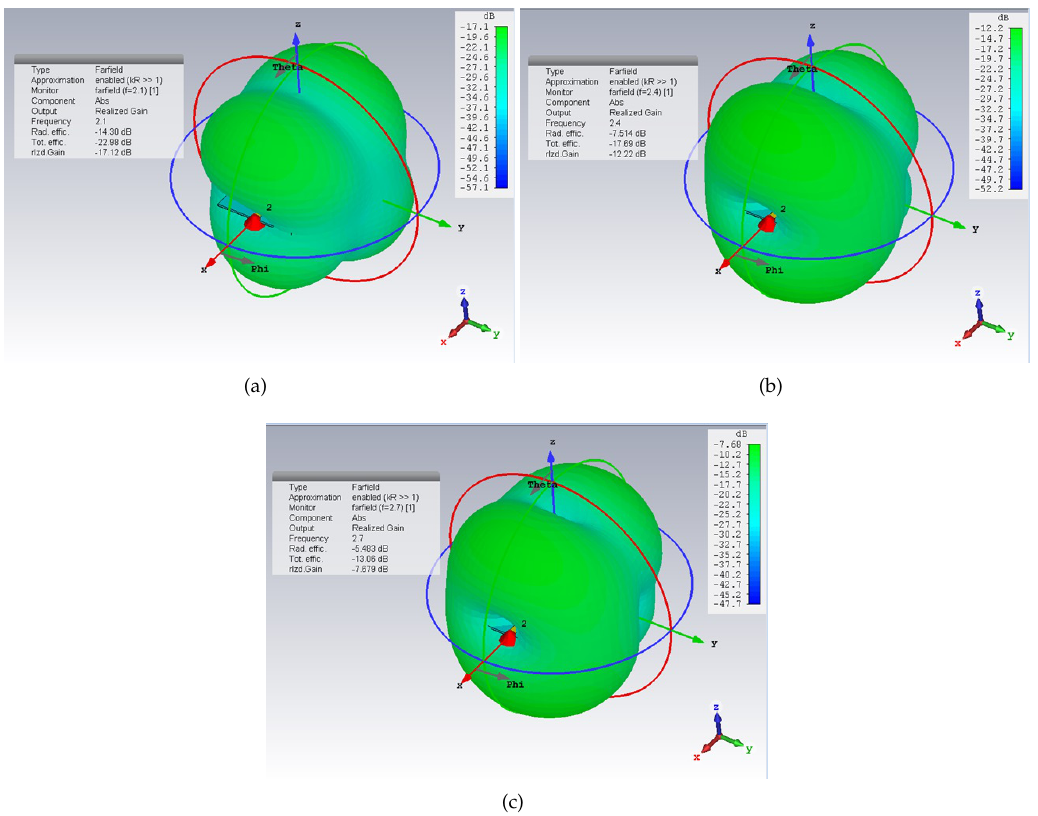
Figure 2. Far-field radiation patterns for the multi-stopband device: at 2.1 GHz ( a ); at 2.4 GHz ( b ); and at 2.7 GHz ( c ).